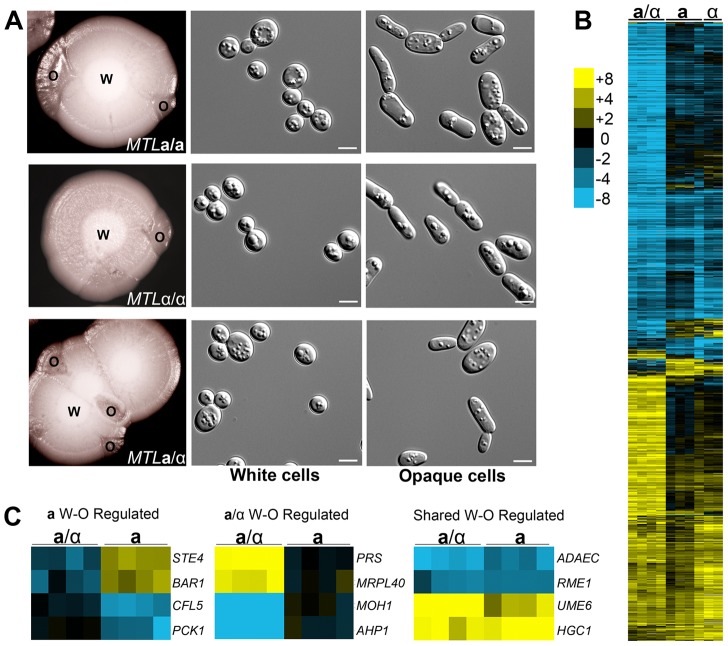

C. tropicalis a/α cells undergo a white-opaque phenotypic switch related to that in a and α cells.(A) White (W) colonies sectoring to opaque (O) in a (CAY1503), α (CAY1505), and a/α (CAY1511) strains and the corresponding cell morphologies observed from these colonies. Cells were grown in SCD at 37°C for 5 days and plated to Lee's + N-acetylglucosamine at room temperature for 10 days. Scale bars = 5 µm. (B) Opaque-white gene expression profiles of a/α, a, and α cells. cDNA prepared from white and opaque states of CAY1511 (a/α), CAY1504 (a), and CAY1505 (α) in independent experiments was hybridized against a universal reference. Opaque cell gene expression was divided by that in white cells and filtered for genes with a fold-change greater than 4 and clustered by Average Linkage Clustering. Genes with elevated expression in white cells are shown in blue and genes upregulated in opaque cells are shown in yellow. (C) Examples of genes whose expression was white-opaque regulated in a cells (left), a/α cells (middle), or in both a and a/α cells (right).